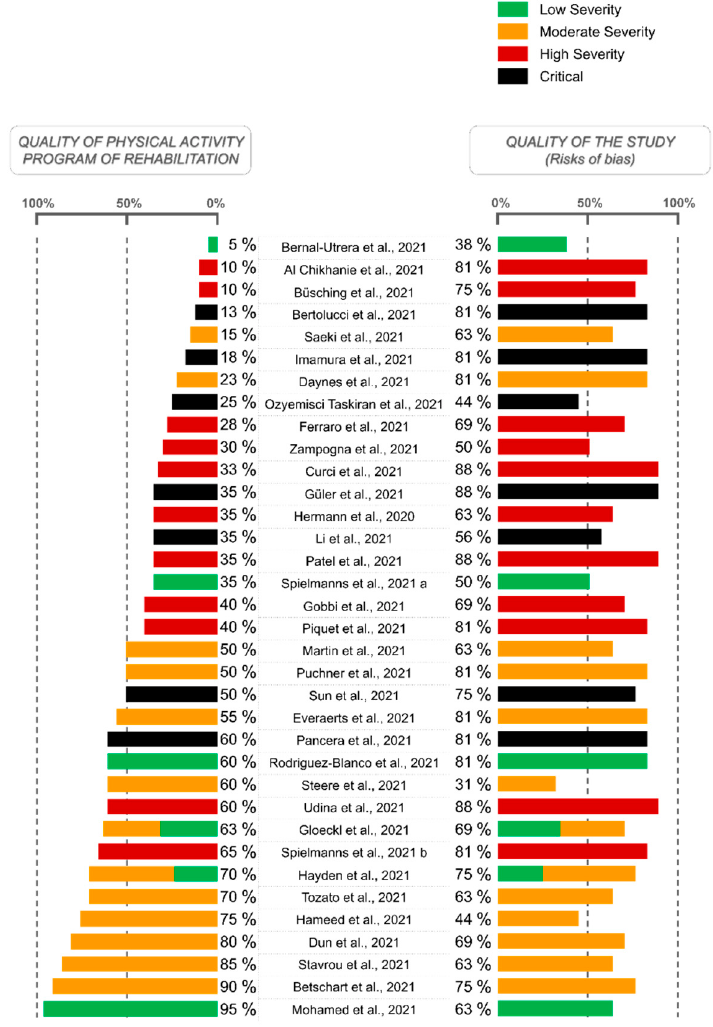
Figure 3. Physical activity program scoring to assess the quality of the description in relation to